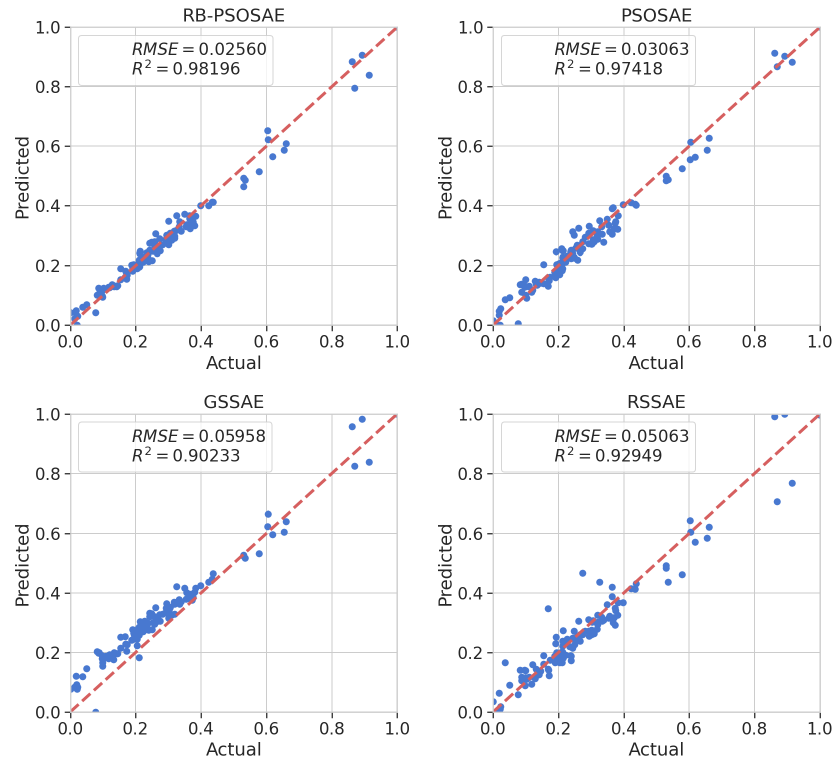
Figure 6. Real values of butane content and the predicted values using RB-PSOSAE, PSOSAE, GSSAE, and RSSAE search